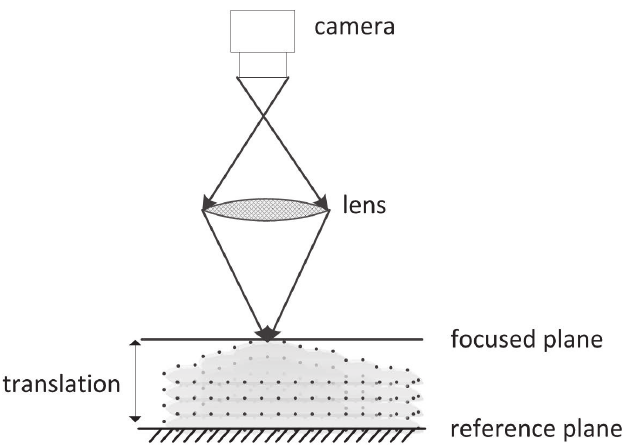
Figure 1. Basic schematic of shape from focus